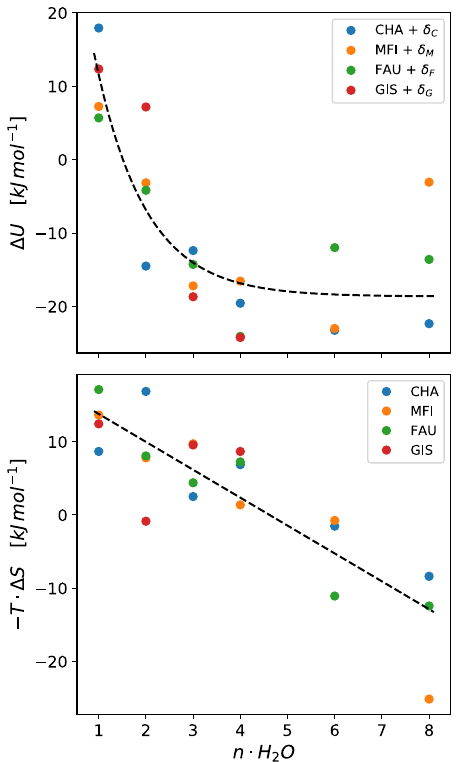
Fig. 7 Enthalpic and entropic component decay. Exponential and linear decay of the enthalpic (top panel) and entropic (bottom panel) contributions to the generation of the hydrated hydronium ion.